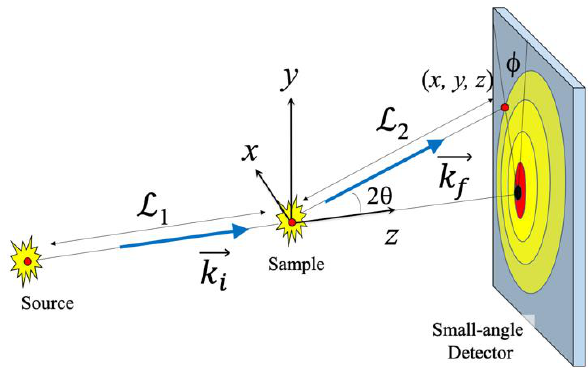
Figure 5. Schematic diagram of scattering geometry. The sample position is ℒ 1 from a neutron source, and a large area detector is ℒ 2 from the sample. The orthogonal coordinate is defined as the x- and y-axes parallel to the detector surface, and the z-axis is parallel to the incident neutron beam ( 𝑘 𝑖 ⃗⃗⃗⃗ ). A scattering vector (𝑞⃗ ) is defined using the scattering angle (2 θ ) , 𝑘 𝑖 ⃗⃗⃗⃗ , and the scattering neutron ( 𝑘 𝑓 ⃗⃗⃗⃗⃗ ).